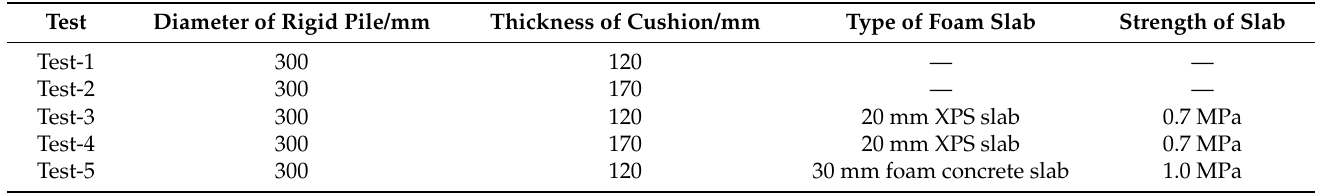
Table 2. Model test